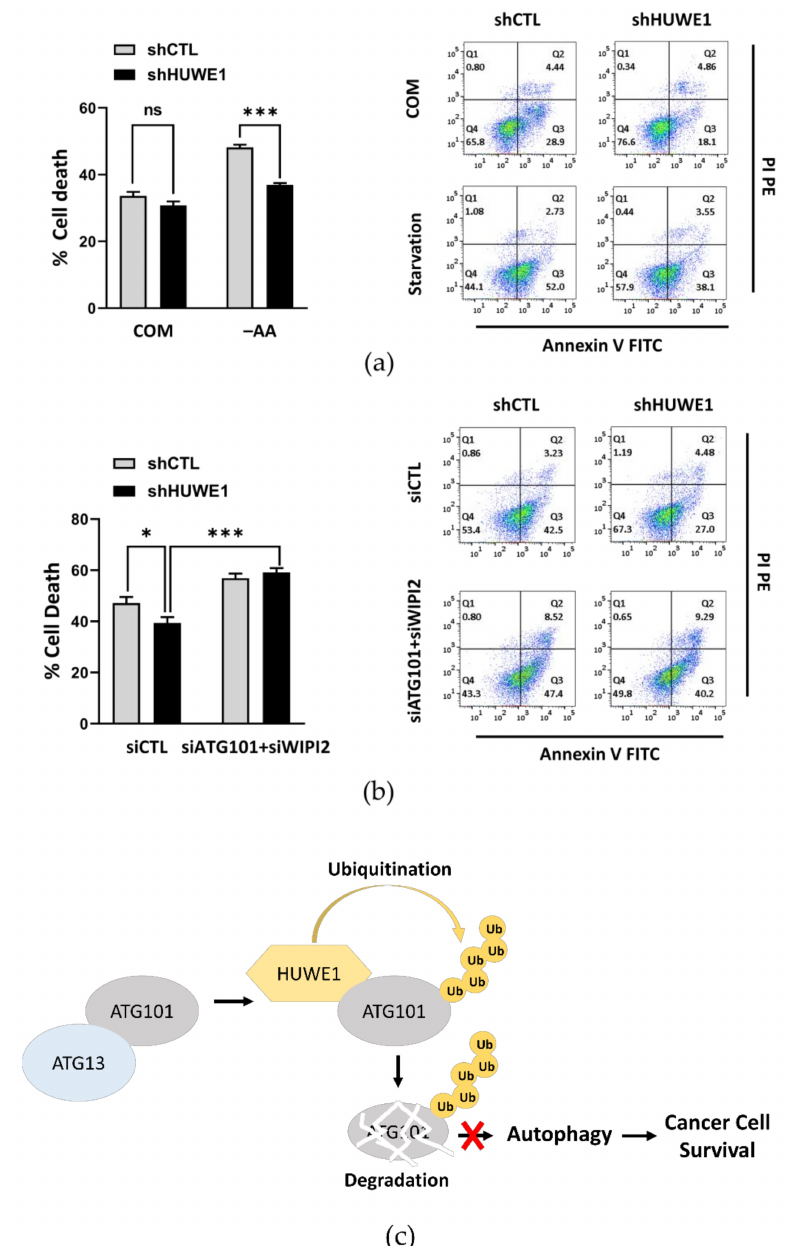
Figure 5. ATG101-mediated autophagy supported while HUWE1-catalyzed ubiquitination of ATG101 reduced cancer cell survival. ( a ) Knockdown of HUWE1 reduced the apoptotic death of cancer cells under nutrient starvation as assessed by Annexin V/propidium iodide (PI) staining and flow cytometry. shCTL or shHUWE1 MIA PaCa-2 cells were plated overnight and incubated in amino acid deprivation (–AA) medium for 48 h. Error bars indicate the mean ± SEM of three independent experiments. *** p < 0.001. ( b ) Additional knockdown of ATG101 and/or WIPI2 further enhanced cell death in HUWE1 knockdown cells. shCTL or shHUWE1 MIA PaCa-2 cells were transfected with WIPI2 and/or ATG101 siRNA for 24 h and subsequently incubated in HBSS for 24 h. Cell death was analyzed as in ( a ). Error bars indicate the mean ± SEM of three independent experiments. * p < 0.05; *** p < 0.001. ( c ) Schematic diagram of HUWE1 targeting ATG101 for ubiquitination and degradation, promoting cancer cell death via blocking autophagy activation under metabolic